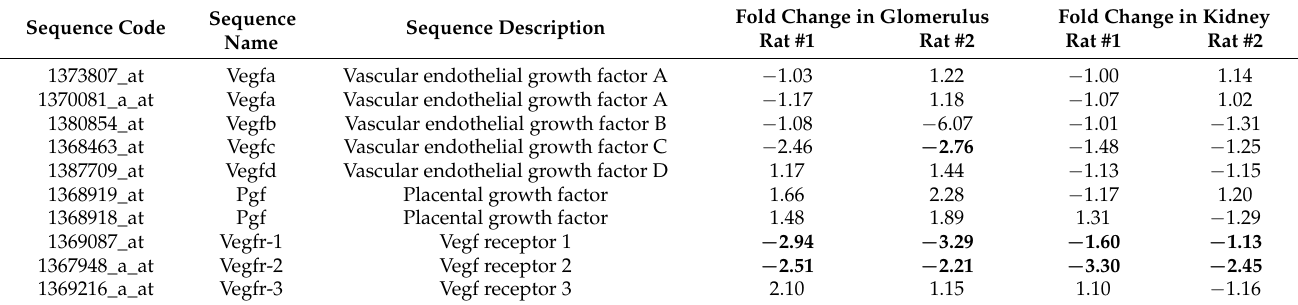
Table 3. Gene expression changes of VEGFs or VEGFRs in glomerular and kidney samples from rats treated with ABT-123 at 10 mg/kg/day for seven